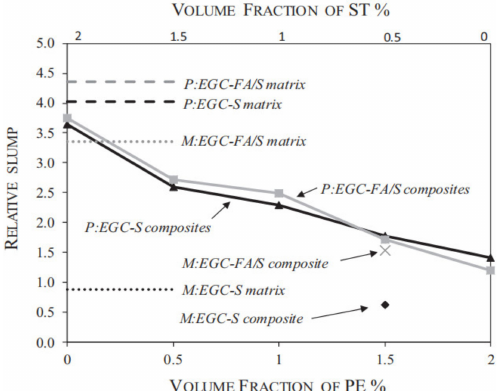
Figure 1. Relative slump versus PE and ST fiber volume fractions, Adapted with permission from [69], copyright 2018